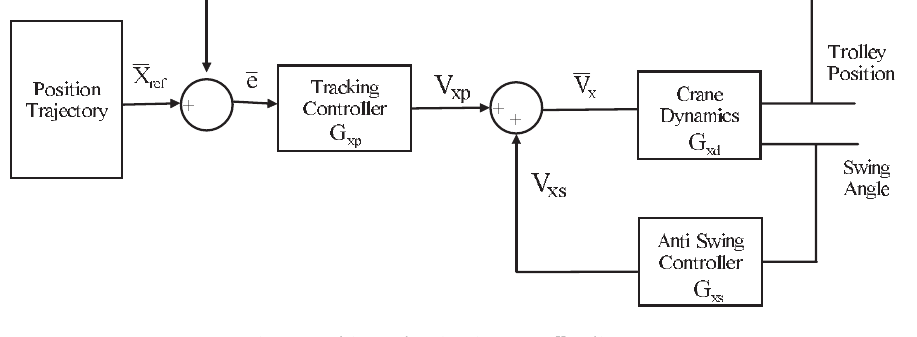
Fig. 4. Tracking and anti-swing controller